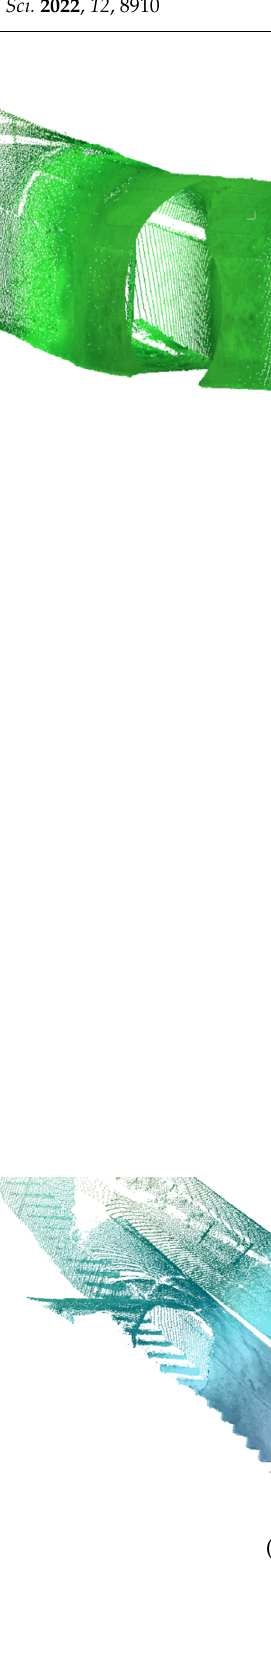
( c ) Figure 10. Conversion of RGB image and depth image into point cloud data. ( a ) Color image; ( b ) Depth image; ( c ) Point cloud. After obtaining the key frame point cloud model of each shaft roadway, it was nec- essary to carry out point cloud registration on the point cloud data of different key frames.